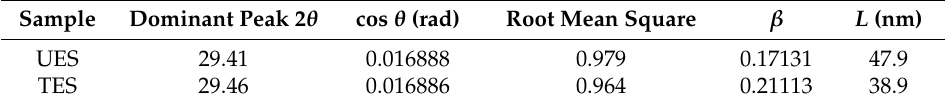
Table 3. XRD crystallite size parameters of UES and TES particles.